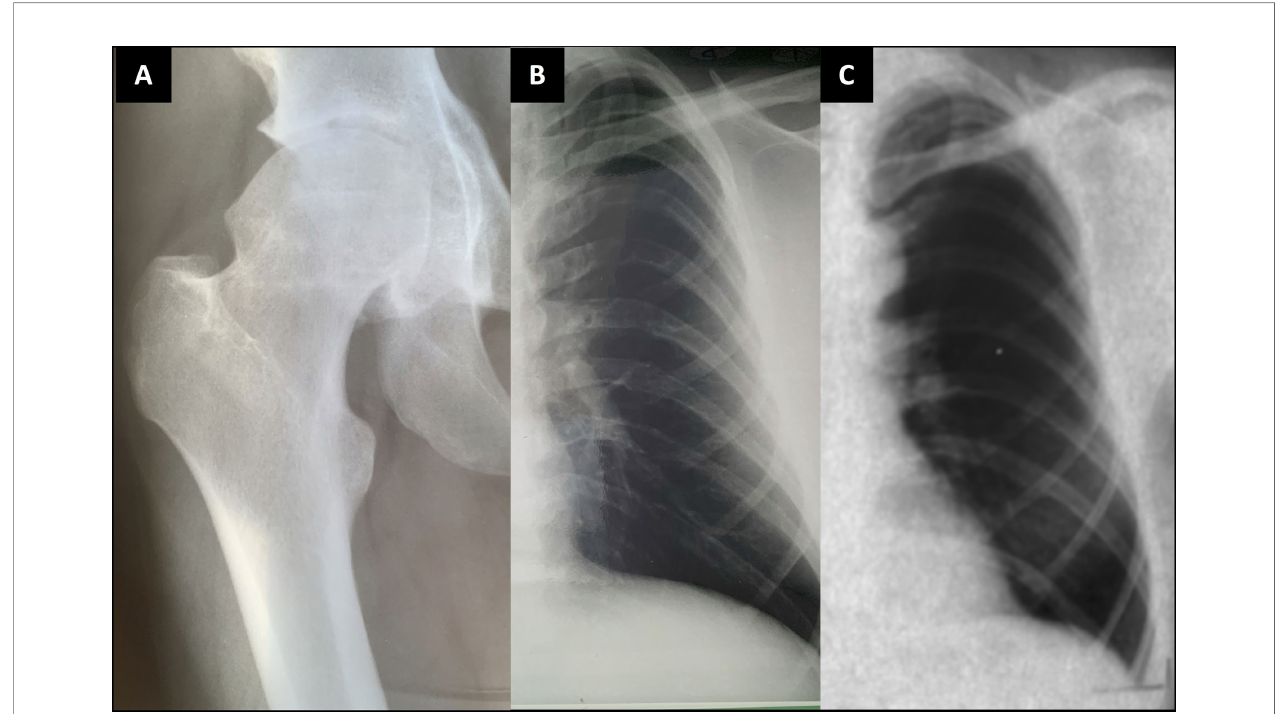
FIGURE 5 | Plain radiographs of the index patient ’ s father and paternal grandfather. Index patient ’ s father (II-1) at age 24 (A, B) ; and the paternal grandfather (I-1) at age 41 (C) . Images show slender diaphyses in ribs and degenerative changes on articular surfaces in hip joint with acetabular osteophytes and sclerosis and uneven shape in femoral